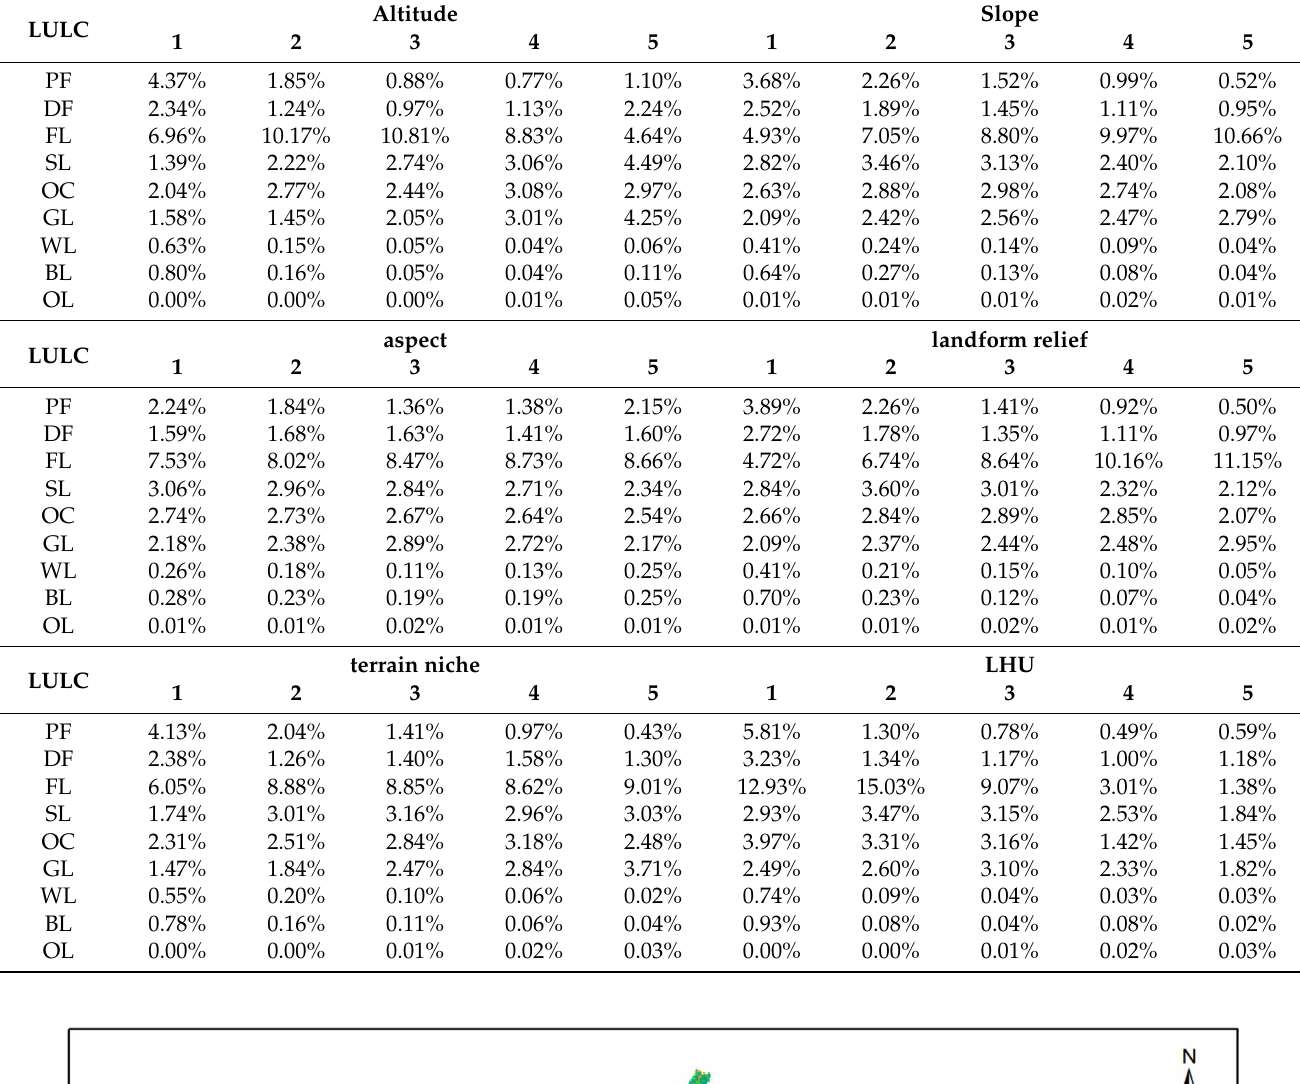
Table 2. Composition of LULC for each terrain gradient and LHU.